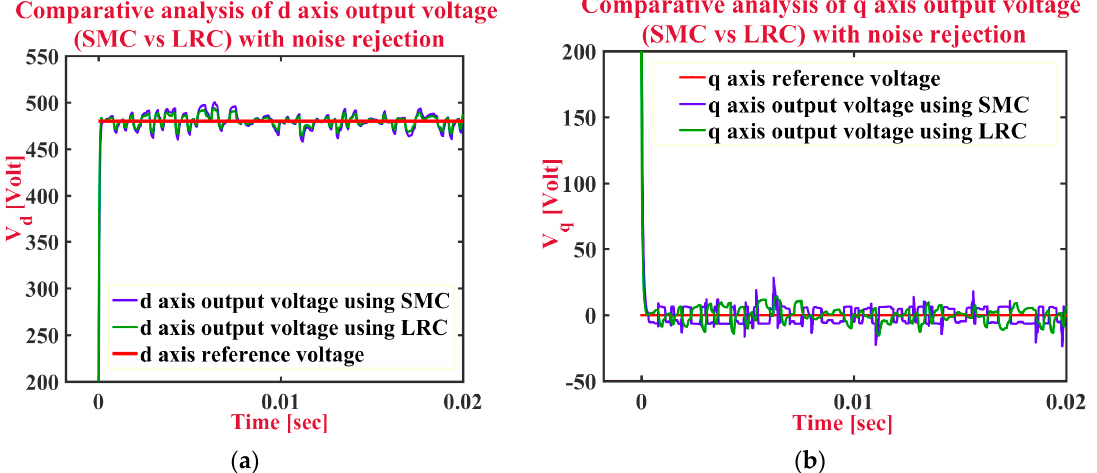
Figure 9. Comparison of performance between SMC (blue colored) and LRC (green colored) for normal condition in case of ( a ) d-axis output voltage; ( b ) q-axis output voltage considering CPL power variation and parametric uncertainties. LRC controller shows considerably better performance than SMC by staying closer to the reference voltage.